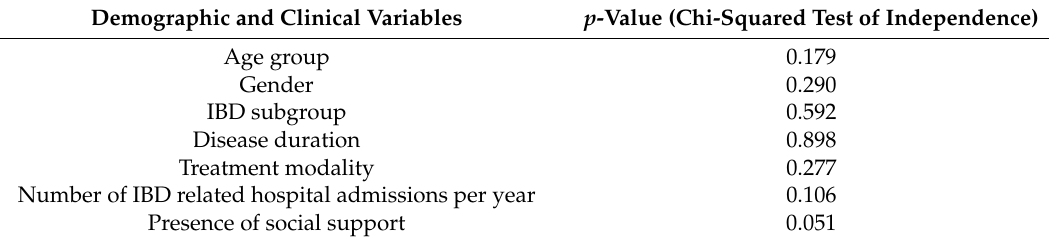
Table 4. Bivariate analysis of demographic and clinical variables with participants’ illness